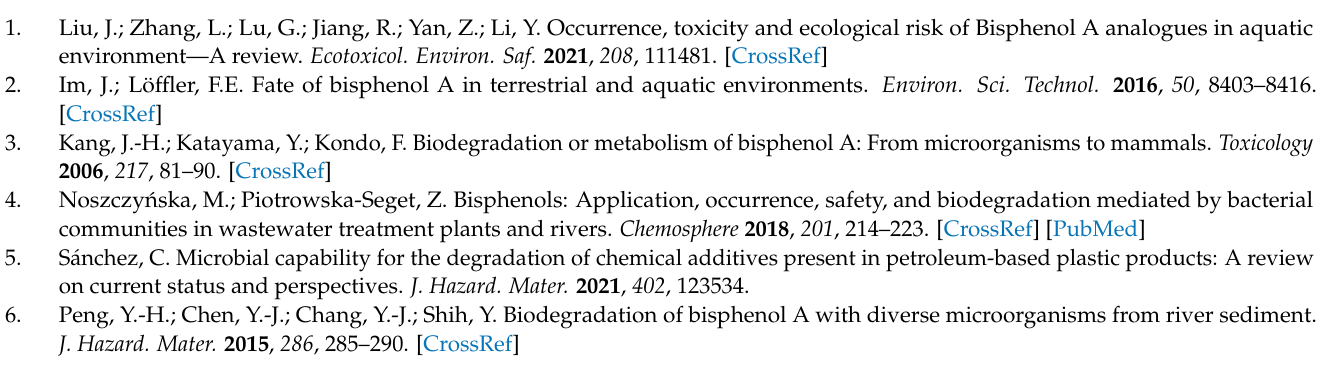
lakes. Figure S2: Linearity obtained during HPLC/UV and HPLC/MS analysis of bisphenol A (BPA) solutions (peak area is in the arbitrary units). Figure S3: Exemplary UV chromatograms obtained at 280 nm (acidified gradient) for BPA stored at sea pure water; the biodegradation process has not been observed. Figure S4: Exemplary UV chromatograms obtained at 280 nm (acidified gradient) for BPA stored at sea water; very slow biodegradation process has been observed. Figure S5: Electrospray ionization mass spectra of Product 1 obtained at different cone voltages (CV); we have checked if the fragment ions have identical retention time as [M-H] − , otherwise we deal with background ions. Figure S6: Product ion spectra of [M-H] − ion of 2,2-bis(4-hydroxyphenyl)-1-propanol. Figure S7: Exemplary HPLC/UV chromatograms obtained at 280 nm and single ion chromatograms of ions at m/z 227 and 135 ([M-H] − of BPA and para -hydroxyacetophenone (p -HAP), respectively) obtained using non-acidified gradient. Figure S8: Exemplary ESI mass spectra of p